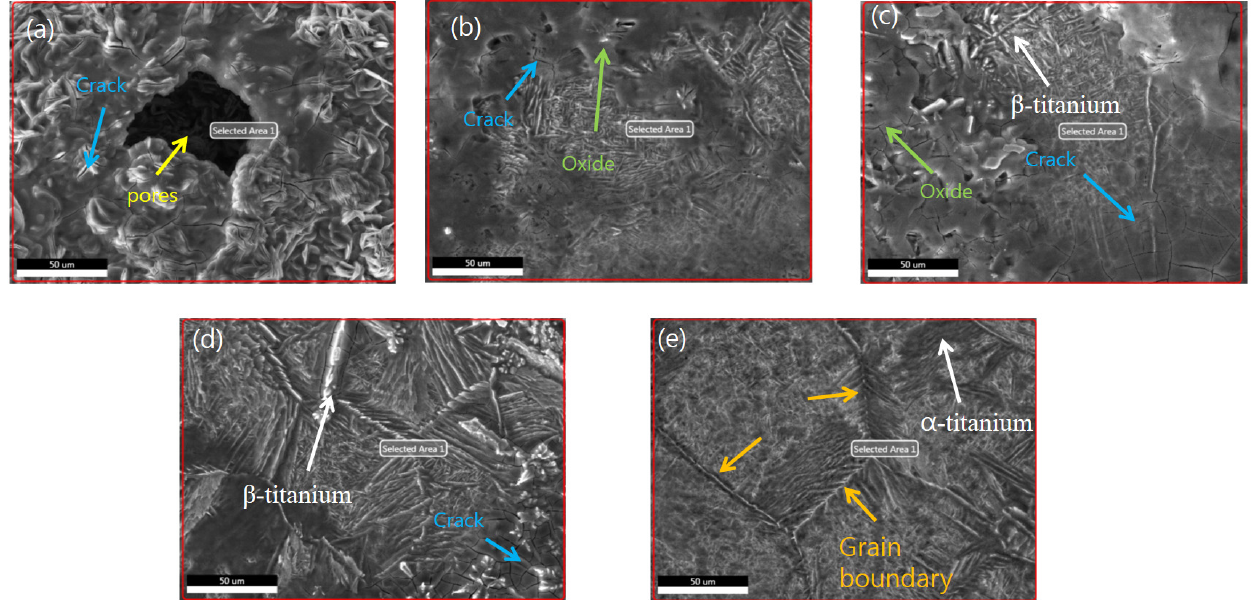
Figure 4. Microstructures of deposited titanium alloys 50 µm: ( a ) Laser power: 800 W, Powder feed rate: 14 g/min, Scan speed: 10 mm/s; ( b ) Laser power: 900 W, Powder feed rate: 14 g/min, Scan speed: 10 mm/s; ( c ) Laser power: 900 W, Powder feed rate: 16 g/min, Scan speed: 10 mm/s; ( d ) Laser power: 1000 W, Powder feed rate: 14 g/min, Scan speed: 10 mm/s; and ( e ) Laser power: 1000 W, Powder feed rate: 14 g/min, Scan speed: 11 mm/s.